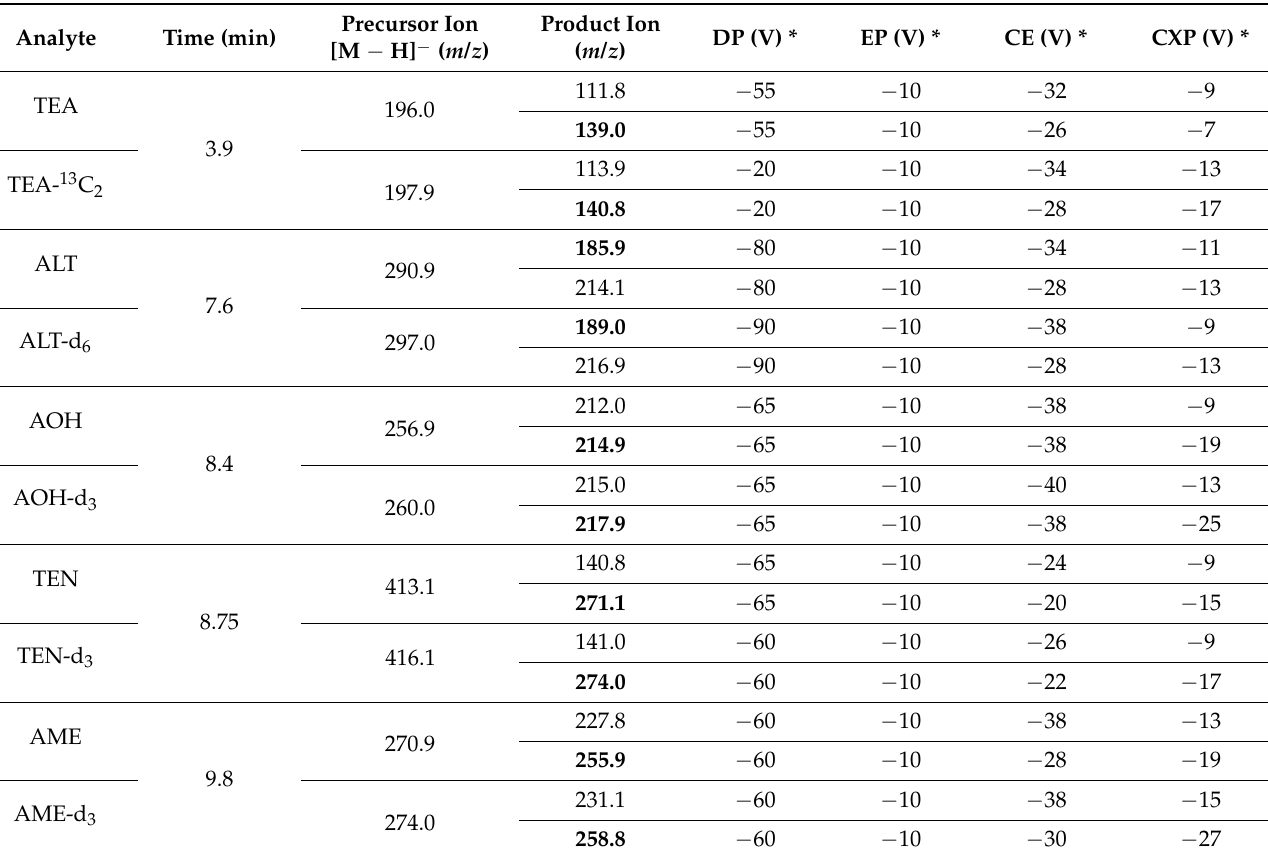
Table 2. Instrumental parameters used in the QTrap 6500 LC-MS/MS system for the detection of the ATs and the respective